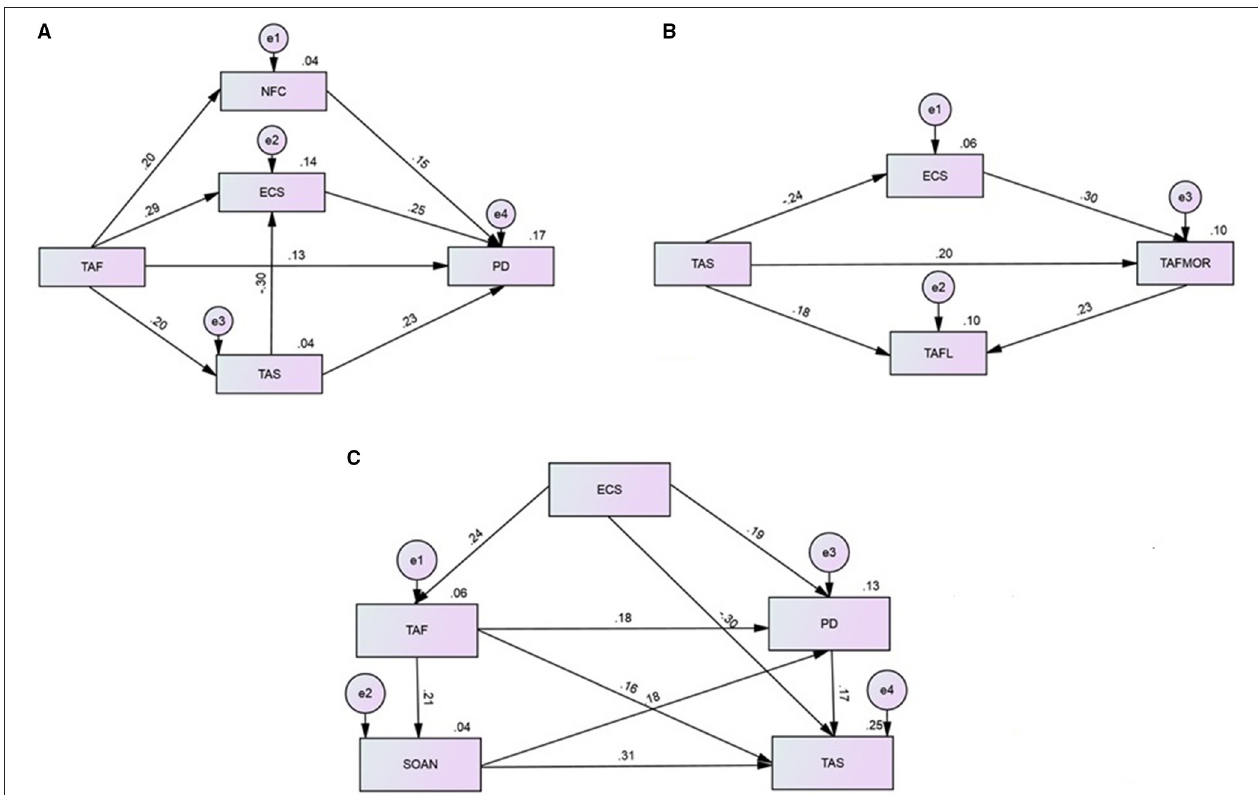
FIGURE 1 | Mediation models showing the relationship between thought action fusion and empathy. (A) Mediation model showing how the effect of TAF on IRI PD subscale scores is mediated by NFC, ECS and TAS scores. (B) Mediation model showing the relationships between TAS, ECS and TAF subscale scores. (C) Mediation model showing the relationships between TAS, ECS, IRI PD, SOAN and TAF scores. Coefficients are shown along each path and R 2 is given above each variable on the right hand side. All paths shown were statistically significant and error variance is shown as “e1” etc. PD, Personal Distress subscale score (of the Interpersonal Reactivity Index); ECS, emotion contagion scale total score; NFCS, need for closure scale total score; SOAN, sense of agency negative subscale score; TAF, thought action fusion scale total score; TAF L, thought action fusion scale likelihood subscale score; TAFM, thought action fusion scale moral subscale score; TAS, toronto alexithymia scale total score (20